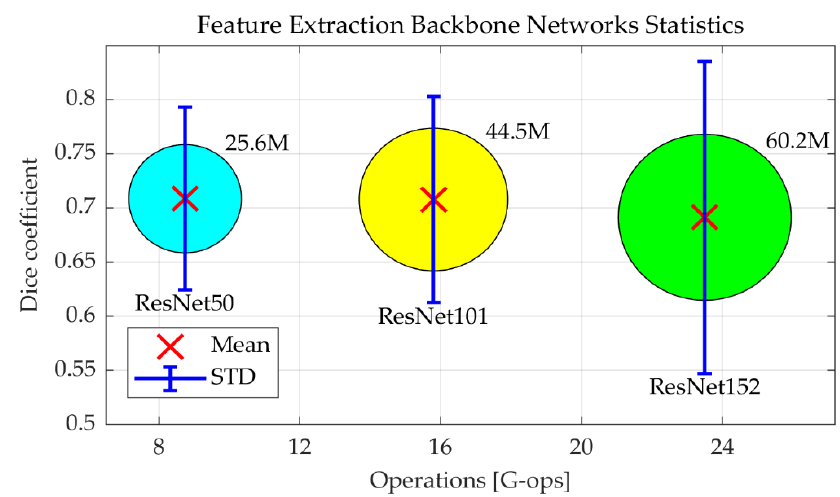
Figure 3. Chart comparing performance of three tested CNNs, explaining the selection of the backbone feature extraction network in the Dilated ResFCN architecture. Number of operations corresponds to a single forward pass of the backbone network. The number of parameters for each network is represented by the corresponding circle [47]. The values shown as red crosses were obtained using Dilated ResFCN architecture with ResNet50, ResNet101, and ResNet152 as feature extraction backbone networks (shown as blue in Figure 2), with the corresponding standard deviation estimates represented by the blue vertical bars.